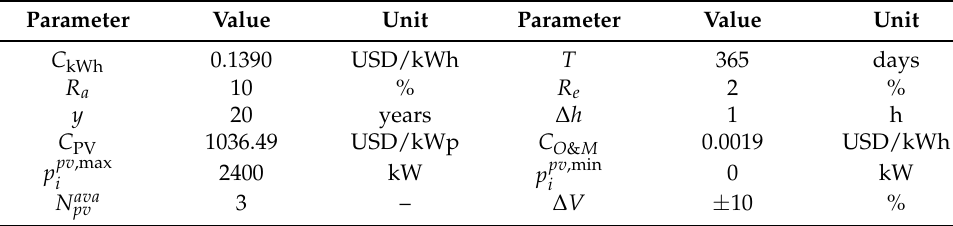
Table 3. Data for evaluating the objective